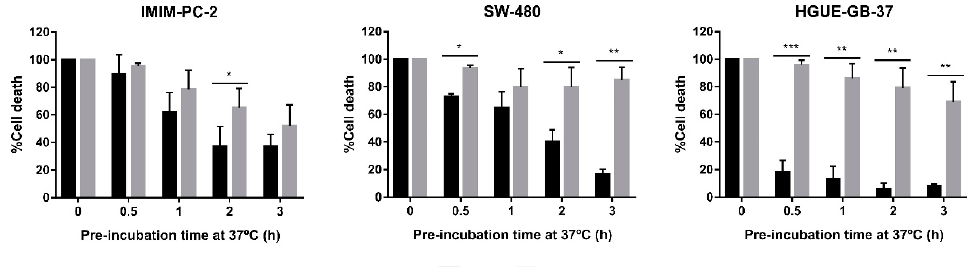
Figure 6. Cell death induced by CLytA-DAAO, free and bound to MNPs, and D-Ala after incubation of the enzyme at 37 ◦ C in IMIM-PC-2 pancreatic carcinoma cell line, SW-480 colorectal carcinoma cell line, and HGUE-GB-37 glioblastoma cell line. Cells were treated with 2 U/mL CLytA-DAAO and 1 mM D-Ala for 24 h. The CLytA-DAAO used was pre-incubated at 37 °C for 30 min, 1, 2, and 3 h before adding it to the cells. Graph shows the percentage of cell death normalizing the treatment with CLytA-DAAO without pre-incubation as 100% ± SD ( n ≥ 3). * indicates a p -value < 0.05, ** < 0.01 and *** < 0.001.